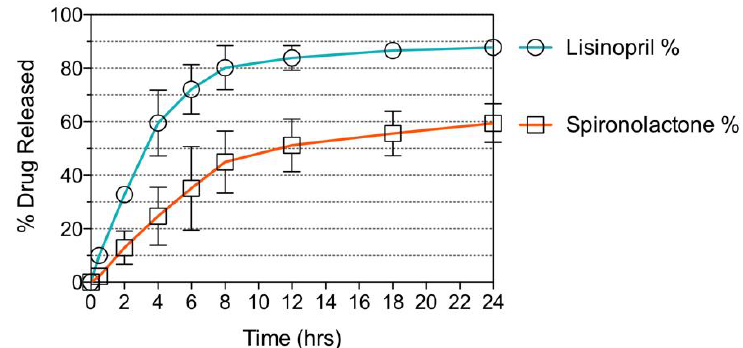
Figure 9. Dissolution test of polypill. A sustained release profile was achieved for both APIs. Around 90% of the lisinopril loaded was release in a period of 24 h, releasing most of the drug within the first 8 h. Above 60% of the spironolactone loaded was released in a period of 24 h.